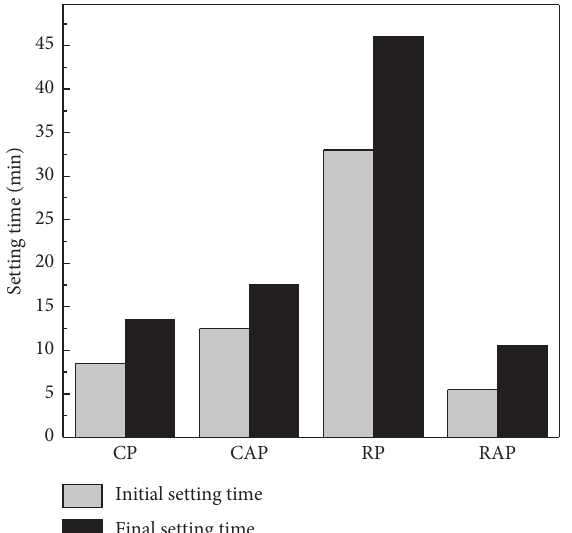
Figure 4: Results of setting time.